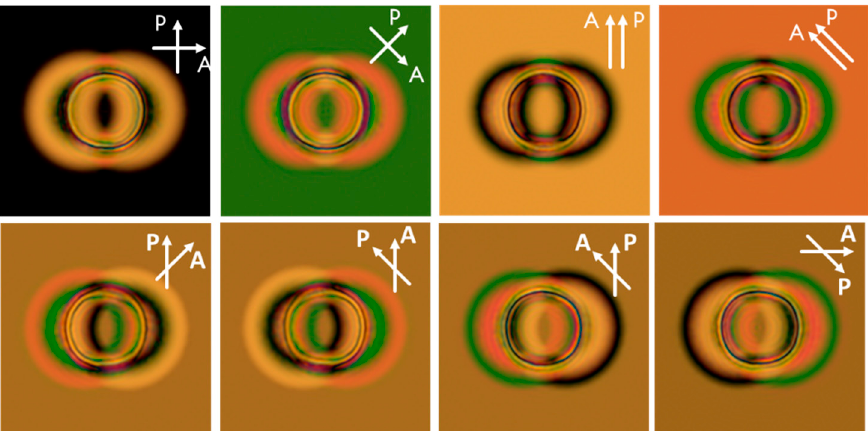
Figure 10. Simulated microscopy images for a 100 µm × 100 µm × 5.5 µm unit cell with dimensions of the patterned rings at the top and bottom substrate r out = 30 µm (r in = 0.4 * r out ) and a shift of 20 µm between the centra at the top and bottom substrate. The results are shown for different orientation of the polarizers.